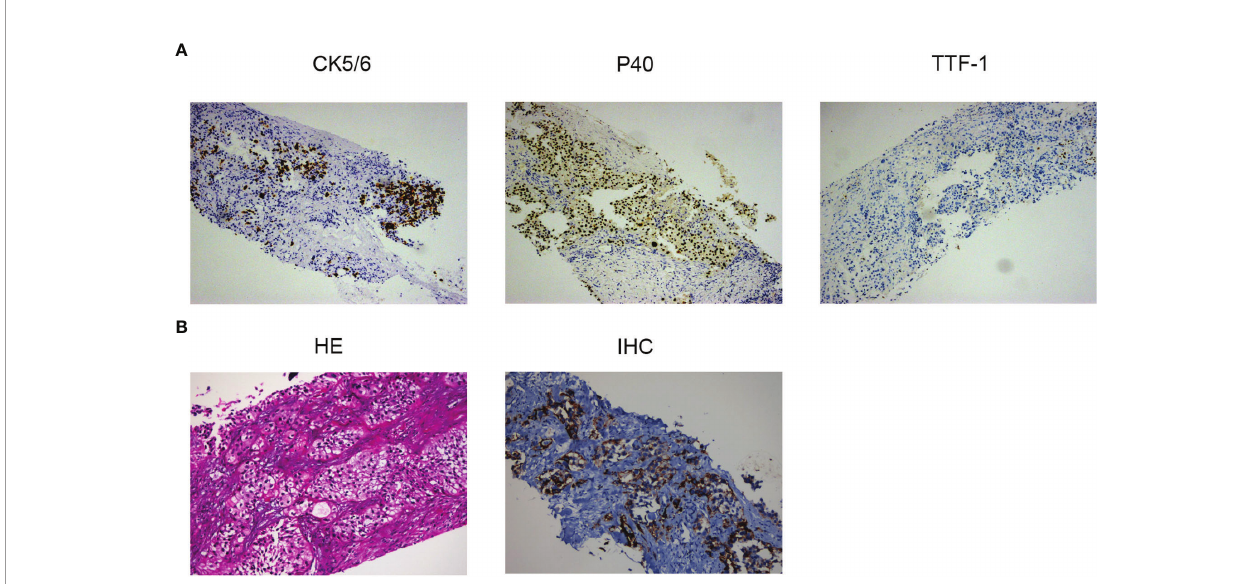
FIGURE 1 | (A) Histopathology of the left upper lobe mass at diagnosis: expression of cell keratin 5/6 and P40 thyroid transcription factor-1 by immunohistochemistry (original magni fi cation, ×10). (B) Pathologic fi ndings of the patient ’ s right kidney metastasis before the sixth-line treatment with camrelizumab: hematoxylin and eosin staining of PD-L1 (original magni fi cation, ×20) and immunohistochemistry of PD-L1 (original magni fi cation,